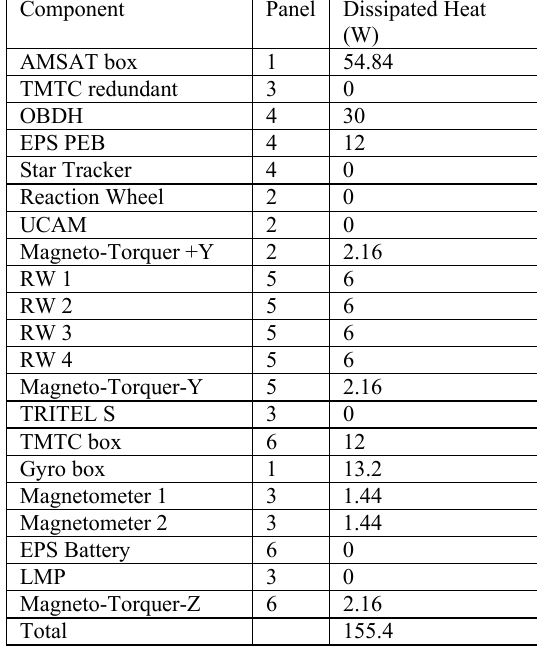
Table A1 Post-mission phase internal equipment heat dissipation